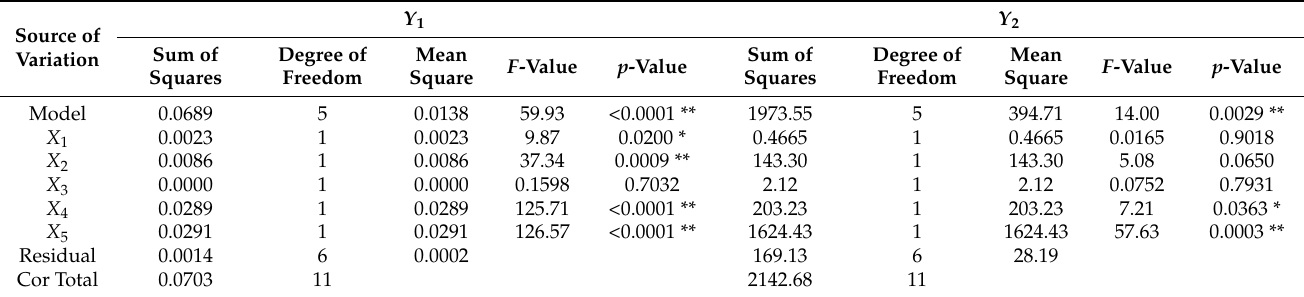
Table 8. Analysis of significance of parameters in Plackett–Burman test.